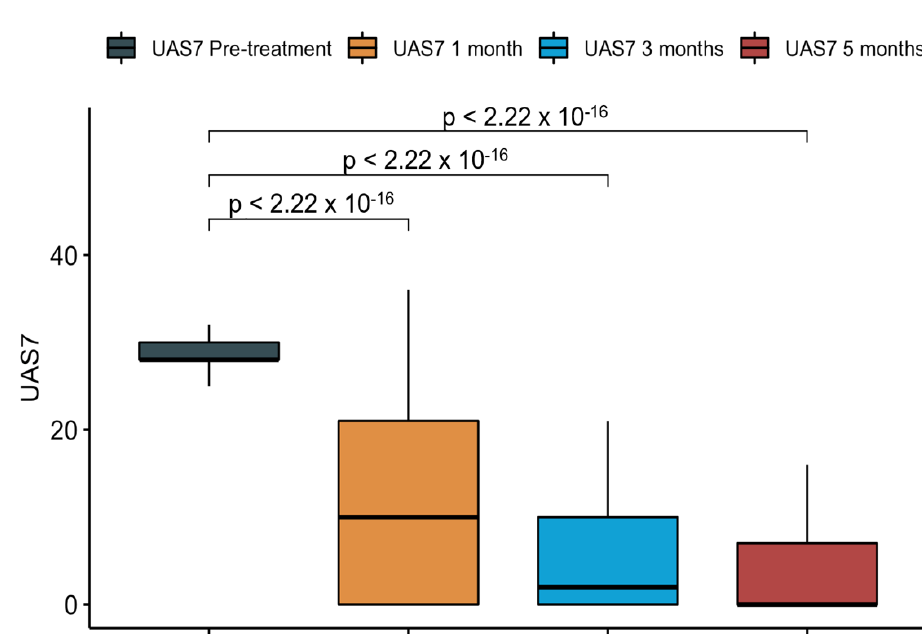
. Figure 3. Response to omalizumab in South Italian CSU patients.